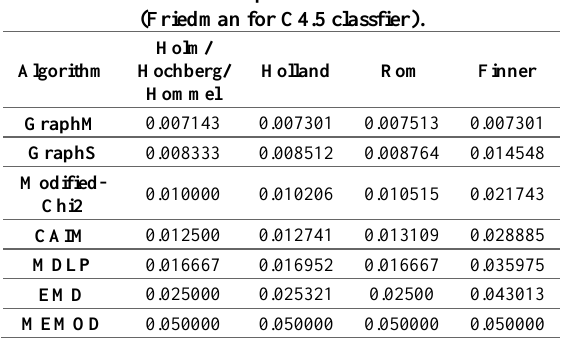
Table 9. Post Hoc comparison Table for 𝜶 = 𝟎.𝟎𝟓 (Friedman for C4.5 classfier).